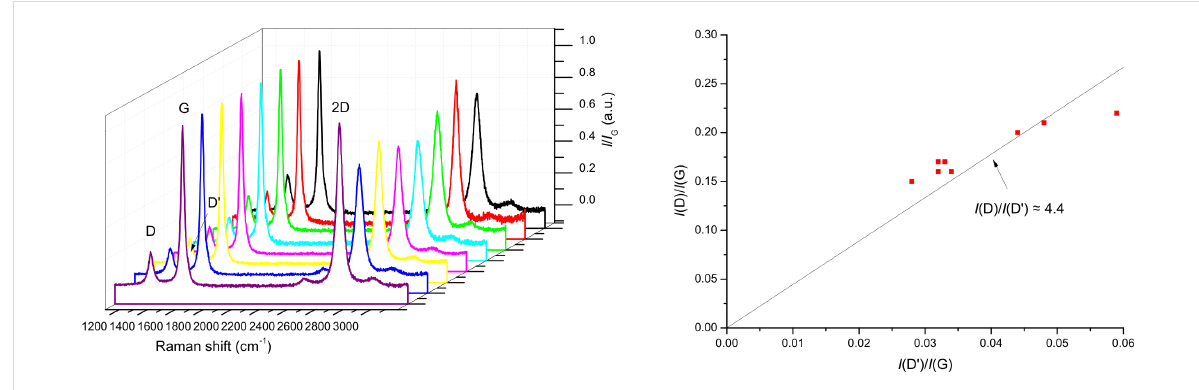
Figure 2: (Left): Raman spectra acquired in different points of the graphene film. (Right): Plot of I (D)/ I (G) vs I (D ′ )/ I (G) referred to the same spectra.